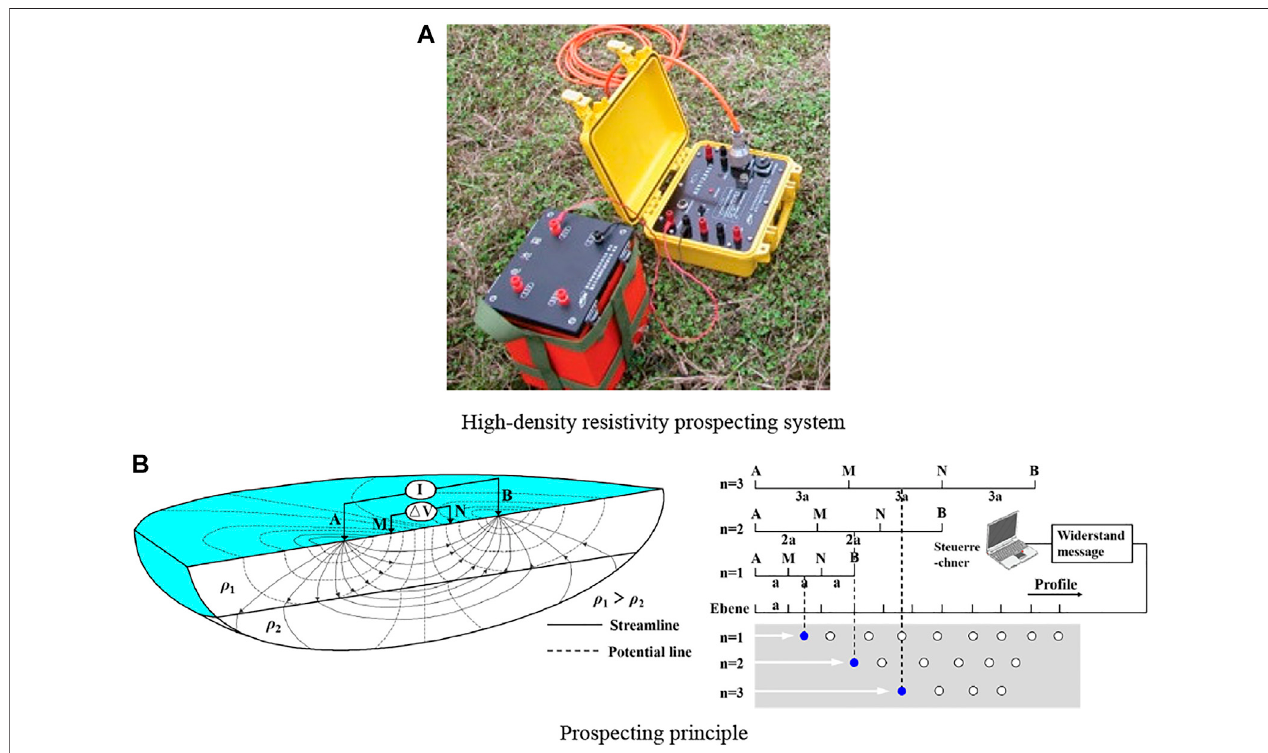
FIGURE 7 | Schematic diagram of the high-density resistivity prospecting method. (A) High-density resistivity prospecting system. (B) Prospecting principle.